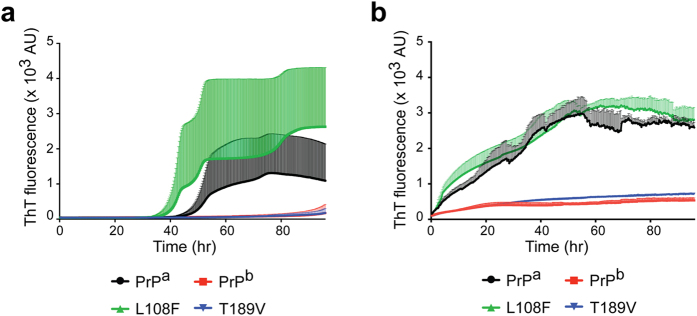
Amyloid fibril growth with recombinant PrPa, PrPb, PrPL108F, or PrPT189V.Thioflavin-T (ThT) kinetics of recombinant PrPa, PrPb, and two derivative mutants (L108F or T189V) in the absence (a) or in the presence (b) of seeds. The seeds used were pre-formed recPrPa amyloid fibrils. Shaded areas are error bars, which indicate standard deviation.